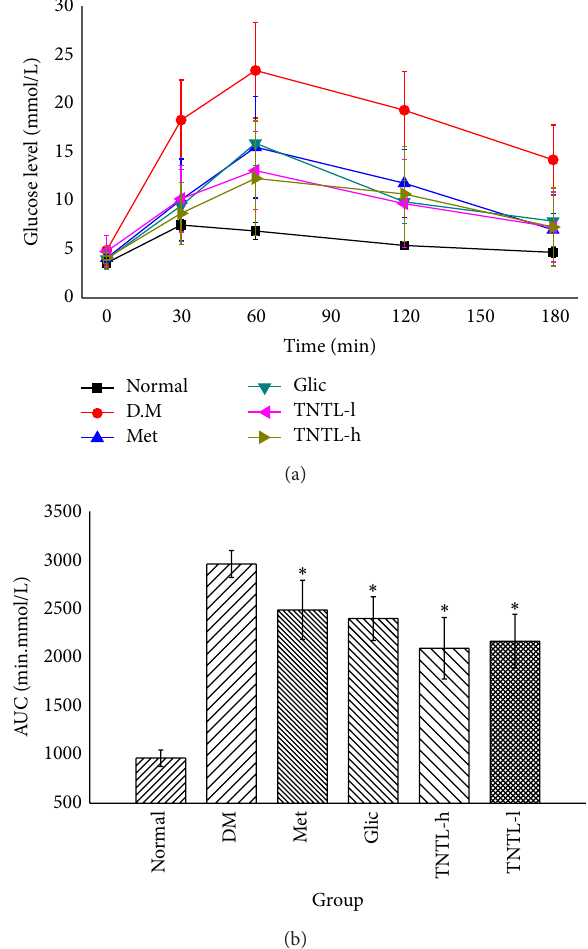
Figure 1: The results of OGTT in STZ-induced diabetic rats. TNTL reduced the blood glucose level (a) after oral high dose of glucose and decreased the area under the glucose response curve (b). Normal: SD without any treatment, DM: STZ-induced diabetic rats without intervention, Met: STZ-induced diabetic rats treated with metformin, and TNTL-h, l: STZ-induced diabetic rats treated with 1.26 g and 0.63 g/kg b.w., respectively. ∗ 𝑃 < 0.05 compared with DM